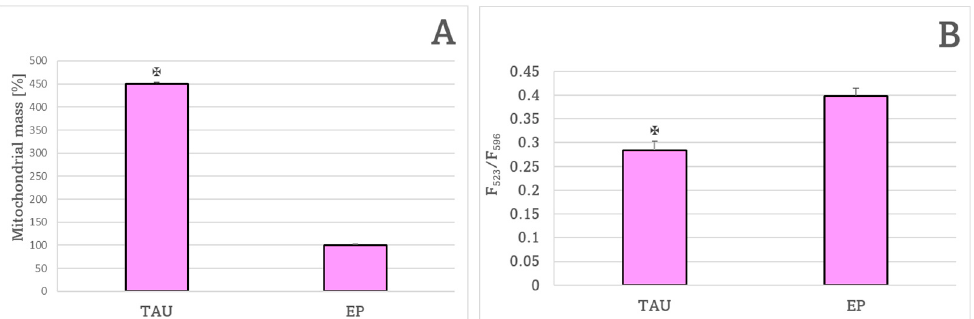
Figure 6. Mitochondrial mass ( A ) and red/green fluorescence ratio of the JC-1 probe, a measure of mitochondrial membrane potential ( B ) after 24-h treatment. ( A ) TAU cells had significantly higher mitochondrial mass compared to EP controls. The mitochondrial mass value obtained for EP cells was assumed as 100%. ( B ) TAU cells showed a significant decrease in the red/green fluorescence ratio of the JC-1 probe compared to EP controls. (cid:122) p < 0.05 with respect to non-treated cells; n = 3. Sensitivity of TAU and EP cells to several compounds affecting the cellular redox equilibrium, both oxidants and antioxidants, was measured and compared. TAU cells